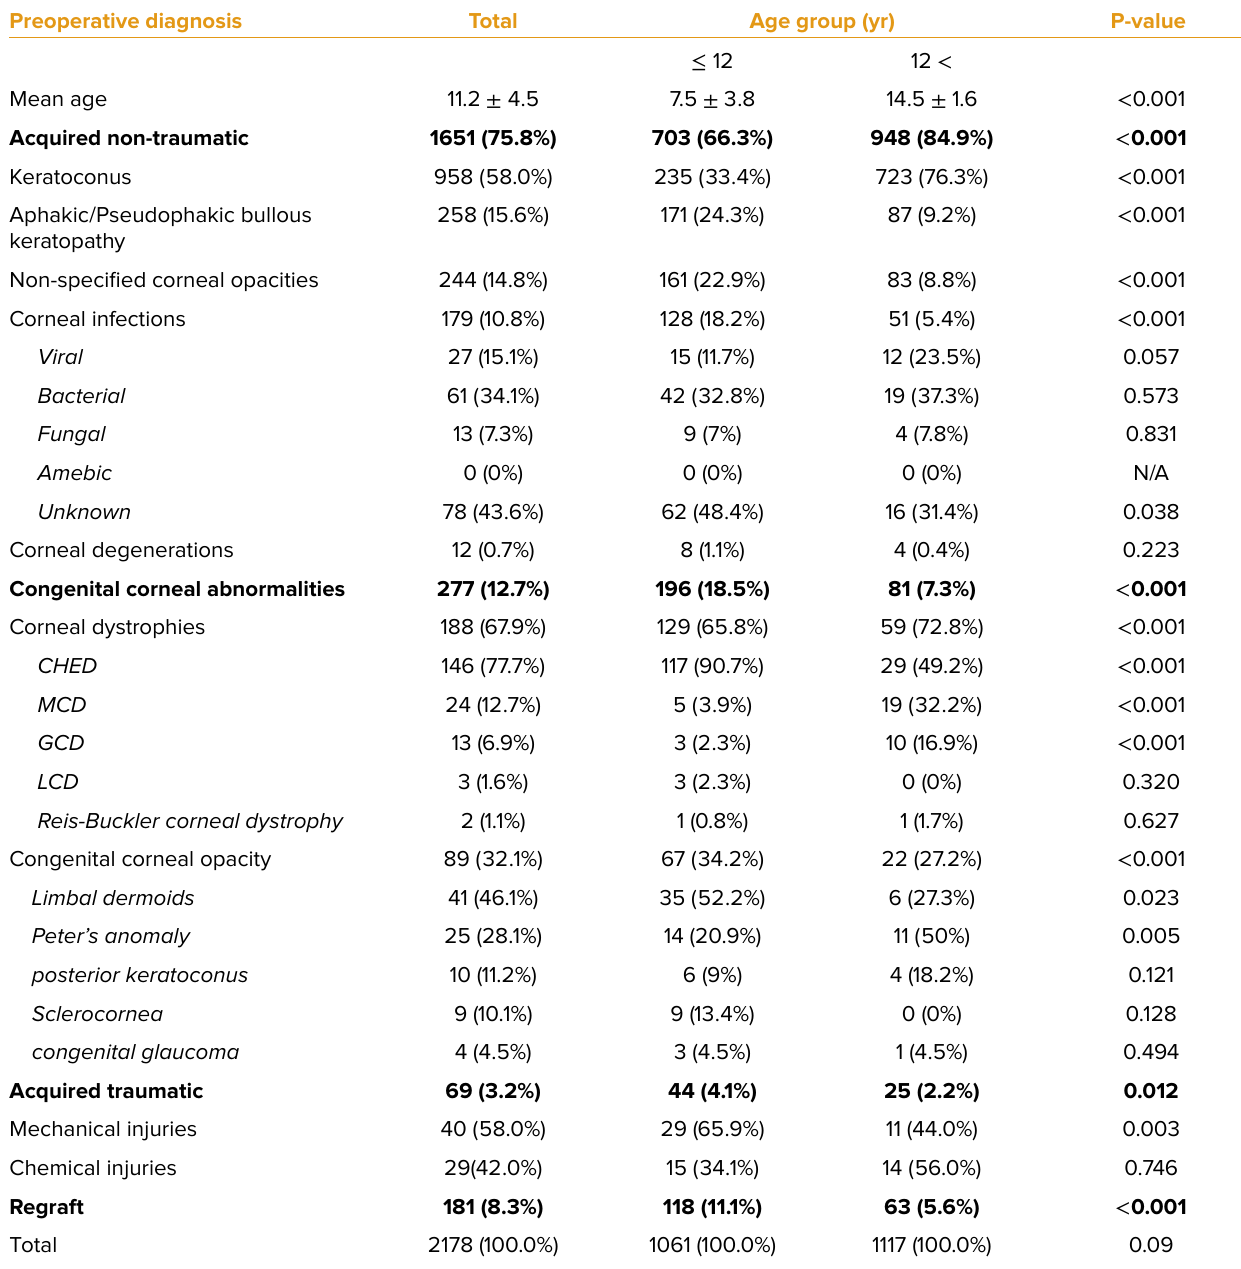
Table 1. Indications for pediatric keratoplasty in Iran between 2006 and 2019 and the corresponding distribution in two age groups of ≤ 12 and > 12